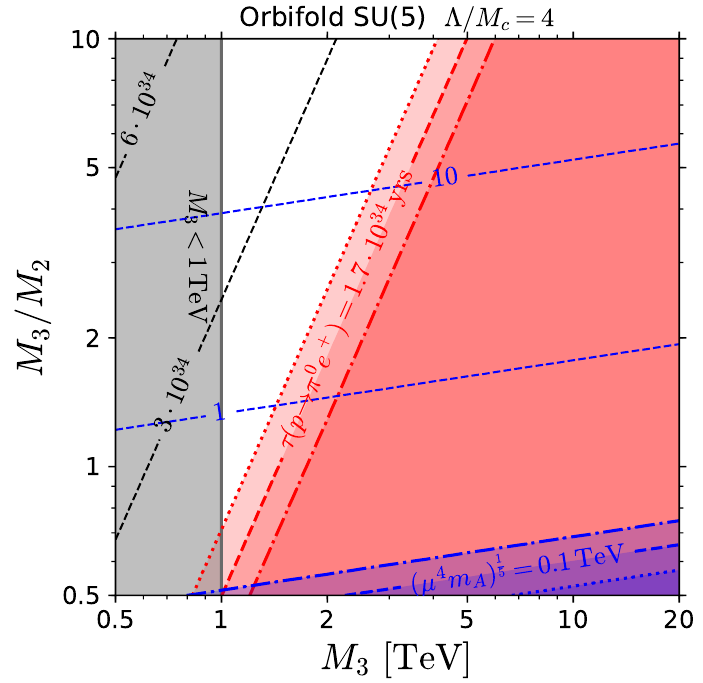
Figure 3 . The M 3 versus M 3 =M 2 plane in the orbifold SU(5) SUSY-GUT model [5] with r = R (cid:3) = 4. The grey shaded region shows a conservative limit on the gluino mass from the direct SUSY searches at the LHC. The blue dashed lines are the contours of ( (cid:22) 4 m A ) 1 5 required by the gauge coupling uni(cid:12)cation. The shaded blue region is phenomenologically excluded due to the presence of too light charginos or non-SM Higgs bosons. The black dashed lines are the contours of the (cid:28) ( p (cid:25) 0 e + ) predicted due to the condition of gauge coupling uni(cid:12)cation. The shaded red region is ! excluded due to the present proton decay bound, (cid:28) ( p (cid:25) 0 e + ) < 1 : 7 10 34 yrs. The black and blue ! (cid:1) dashed lines are obtained using the nominal value of (cid:11) s ( m Z ), whilst the dotted-dashed and dotted lines (red and blue) are obtained using the upper and lower variation of (cid:11) s ( m Z ) corresponding to the 1- (cid:27)